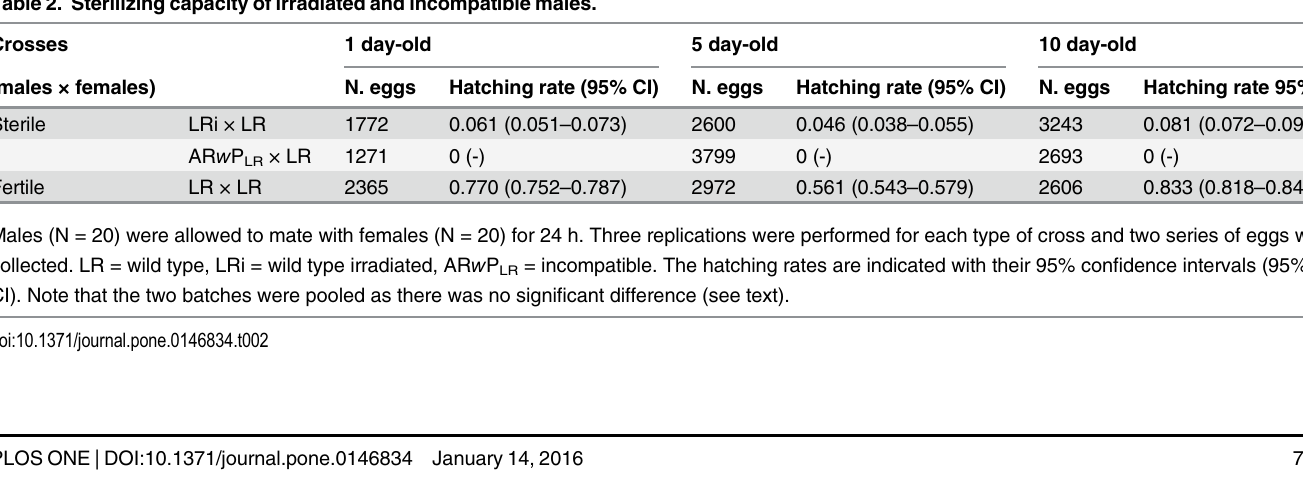
observed trend is that AR w P males tend to induce a lower hatching rate than LRi males LR (Table 3). In the 1:1 ratio, the competitiveness index (C) for LRi males were: -0.031, 0.824 and 1.516; and the induced sterility (IS) was: -2.9%, 41.5% and 54.4% for 1, 5 and 10 day-old males, males were: 0.530, 0.723 and 0.635; respectively (Table 3). The estimated C values for AR w P LR and the IS values were: 34.6%, 41.9% and 38.8% for 1, 5 and 10 day-old males, respectively (Table 3). The comparison of mating competitiveness of LRi and AR w P males in the 1:1 LR ratio showed a better competitiveness of the former at 10 days and of the latter at 1 day, respec- tively; while the difference between the two types of male was not significant at 5 days. When the 5:1 ratio was implemented, the estimated C values were: 0.109, 0.533 and 0.155; and IS val- ues were: 32.6%, 66.8% and 39.4% for 1, 5 and 10 day-old LRi males, respectively (Table 3). As males, the estimated C values were: 0.215, 0.633 and 0.770; and the IS values were for AR w P LR 51.8%, 76% and 79.4% for 1, 5 and 10 day-old males, respectively (Table 3). Thus, the compari- males in the 5:1 ratio showed a better com- son of mating competitiveness of LRi and AR w P LR males regardless of age. petitiveness of AR w P LR Finally, as male mating competitiveness could be affected by size we measured male wings ’ size as a proxy of adult size for all male types. As shown on Fig 1, irradiation of LR pupae did not affect wing size of emerging adults as there was no significant difference between untreated males males and their irradiated counterparts (LRT, F = 2.66, P = 0.11). However, AR w P LR were significantly larger than the other males (LRT, F = 101.4, P < 0.001, Fig 1).